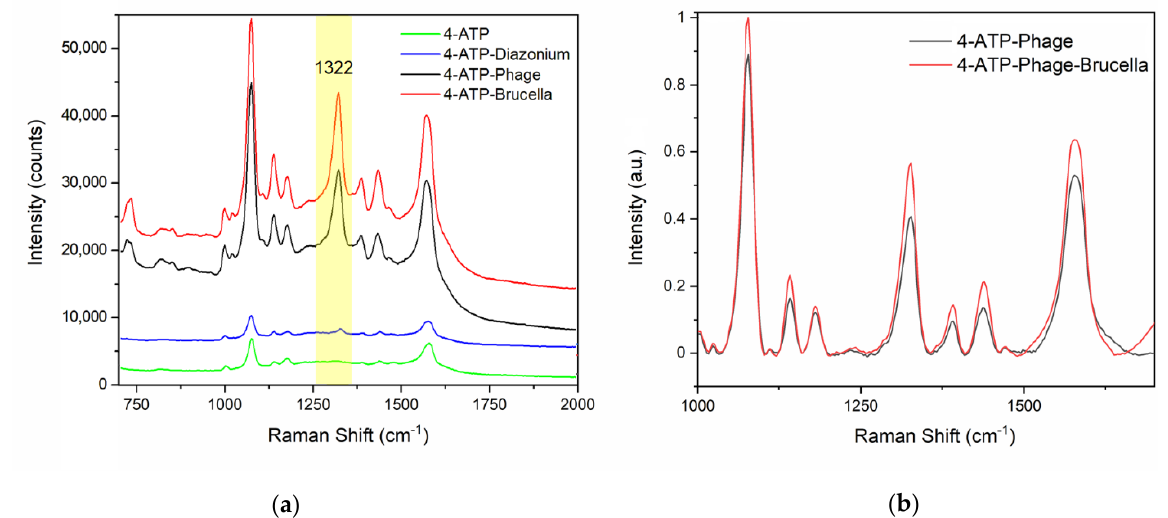
Figure 4. Comparison of SERS measurements performed on our functionalized nanostructures after binding in ddH 2 O. ( a ) Registered SERS spectra of the 4-ATP SAM (green line), the diazonium (4-ATP–N≡N+) (blue curve), the covalently immobilized phage (black curve), and the captured Brucella (red curve). ( b ) Magnification of the SERS spectra referenced to the zero level for the covalently immobilized phage (black curve) and the captured Brucella (red curve).